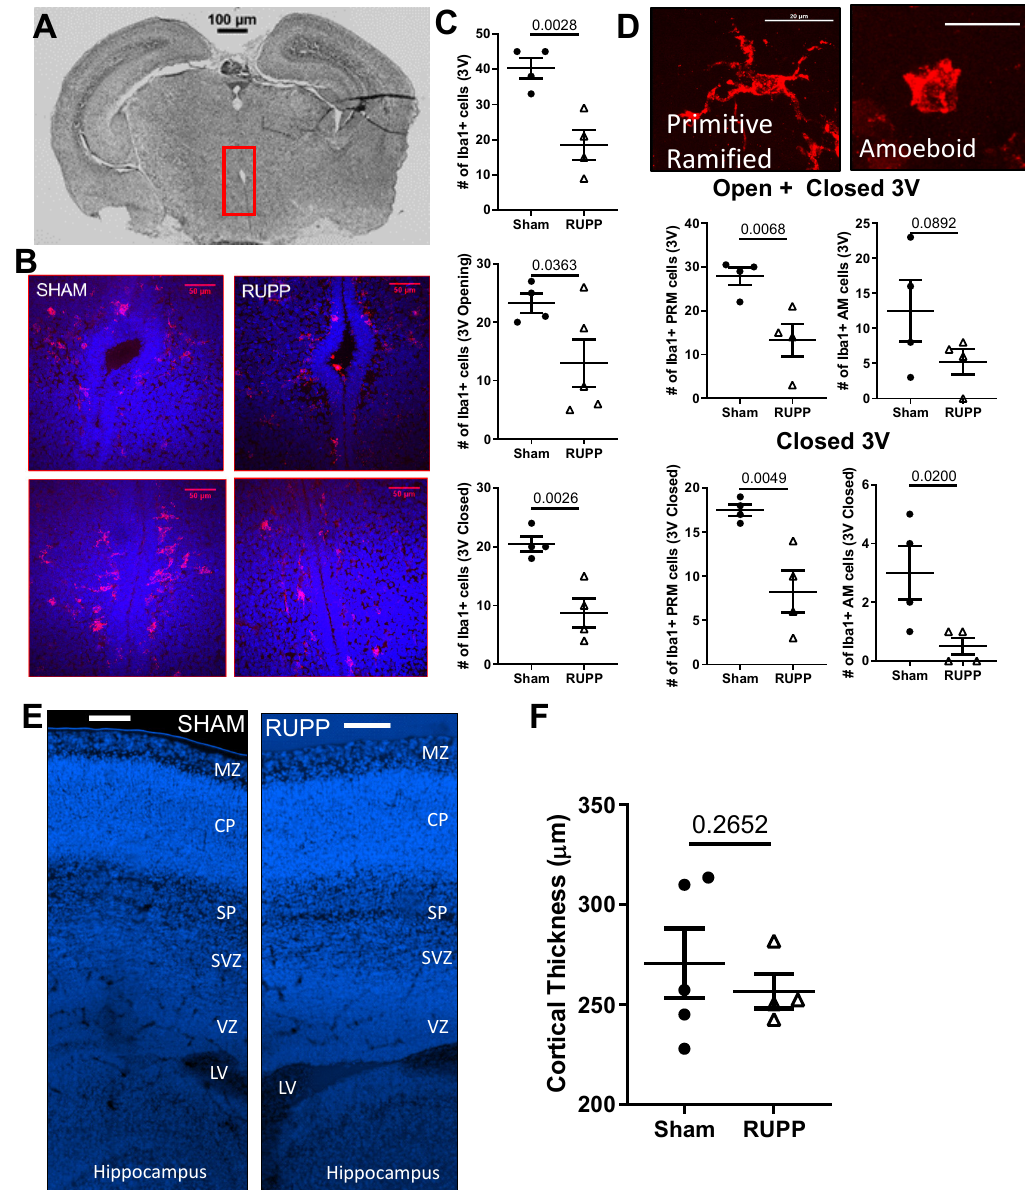
Figure 6. Changes in microglia at the proliferative areas (sub-ventricular zones—SVZ) of the 3rd Ventricle. ( A ) Representative image showing, at the brain-level, the section where the microglial analysis was conducted. Scale bar = 100 µ m. ( B ) Representative images of Iba1 staining in the open region and closed region of the 3rd ventricle. Red—Iba1 + cells; Blue—DAPI + nuclei. Scale bar represents 50 µ m. ( C ) Decreased number of microglia in the SVZ of pups exposed to placental ischemia. ( D ) Examples of di ff erent microglia types observed (scale bar = 20 µ m) and quantification of primitive ramified and amoeboid microglia in SVZ. ( E ) Representative images showing the di ff erent cortical layers in the embryonic day (E19) pup brain. Scale bar represents 100 µ m. ( F ) Quantification of cortical plate thickness in fetuses exposed to sham or placental ischemia. Values from 1–2 pups were averaged per dam ( n = 4–5 per group) and shown along with the mean ± SEM. Data were analyzed using unpaired t -tests, and p -values are indicated. MZ—marginal zone, CP—cortical plate, SP—subcortical plate, SVZ—sub-ventricular zone, VZ—ventricular zone, and LV—lateral